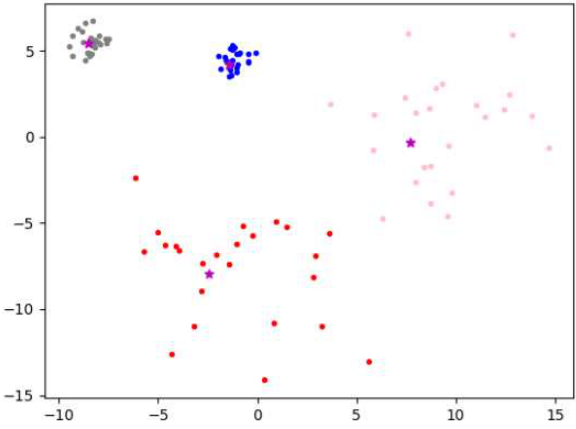
Figure 7. T he γ scatter plot of data1 and data2 ( n = 50). Figure 7. The γ scatter plot of data1 and data2 ( n =